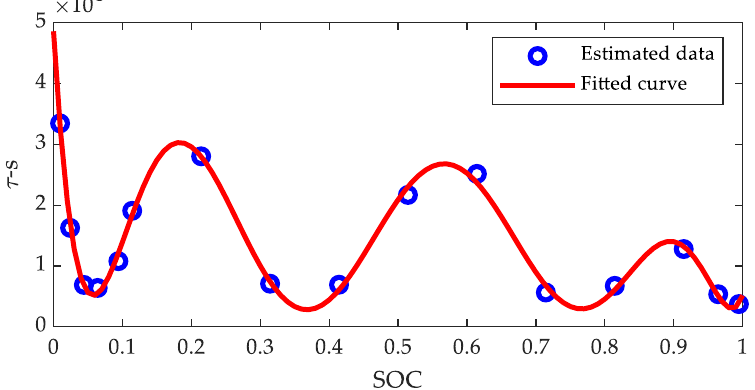
Figure 12. Variation curve of diffusion time constant τ with SOC.